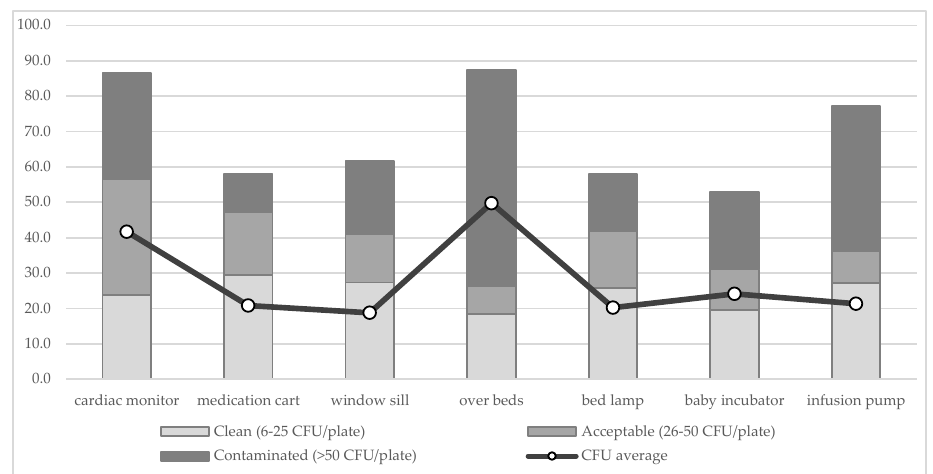
Figure 3. Distribution (%) of samples by surfaces and level of contamination. The points connected with the line show the mean number of CFU/plate of each surface.